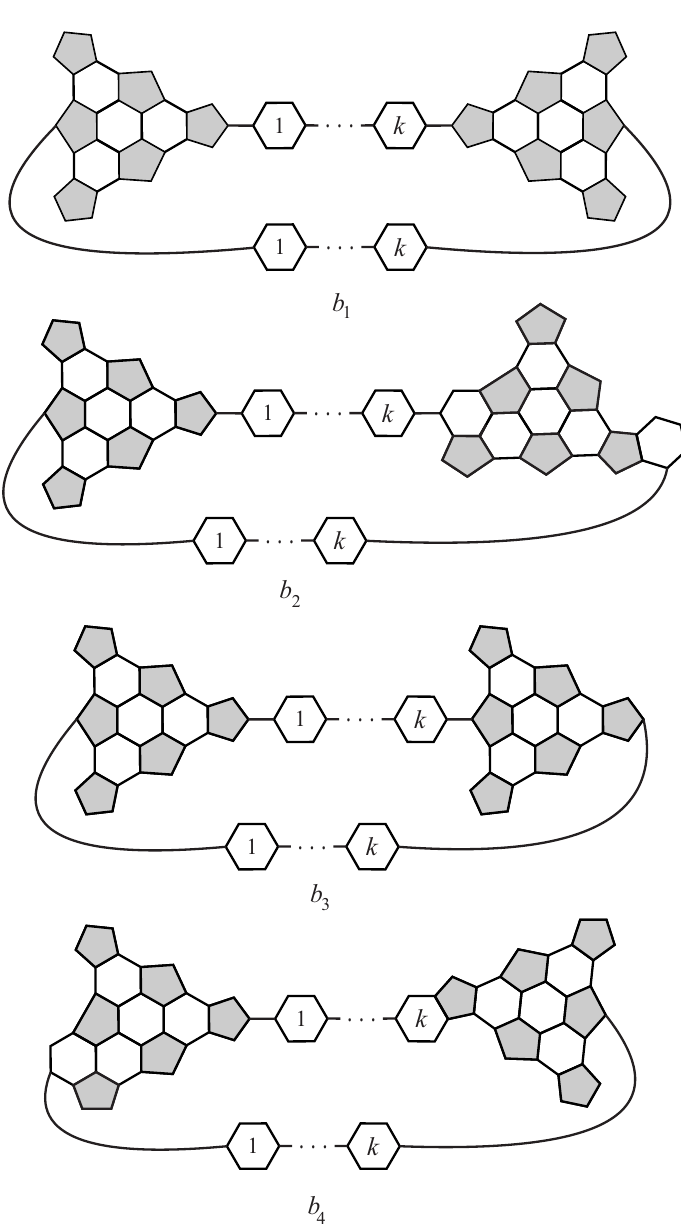
Figure 9. Mutual positions of caps of type b in IPR fullerene